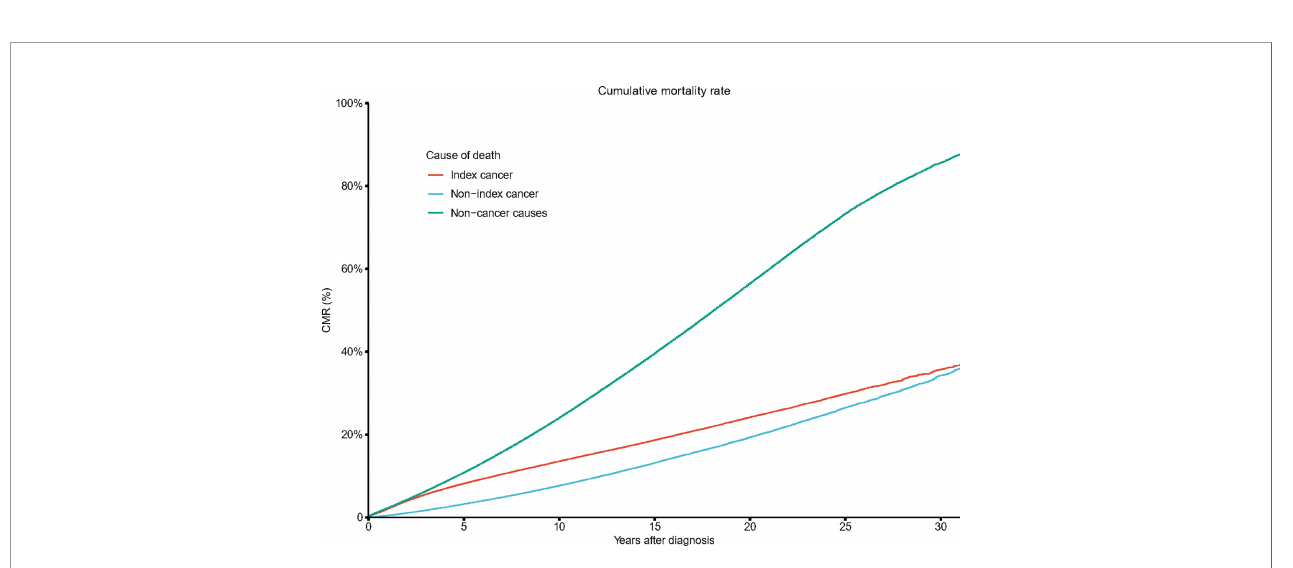
FIGURE 4 | Cumulative mortality rate (SMR) by time after